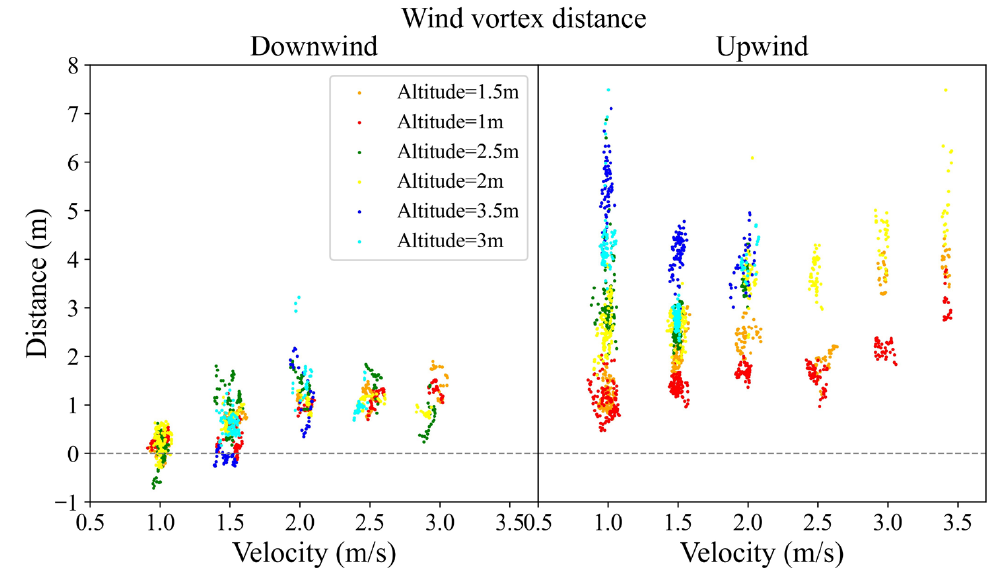
Figure 7. Scatter plot of the wind -vortex distance.